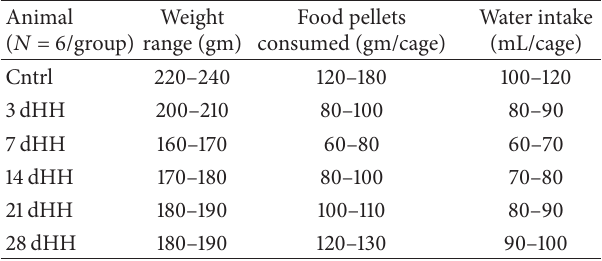
Table 1: Effect on food and water consumption with weight in rats during HH